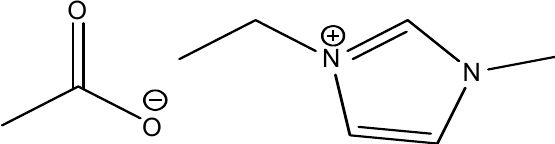
Figure 1. Structure of 1-ethyl-3-methylimidazolium acetate.